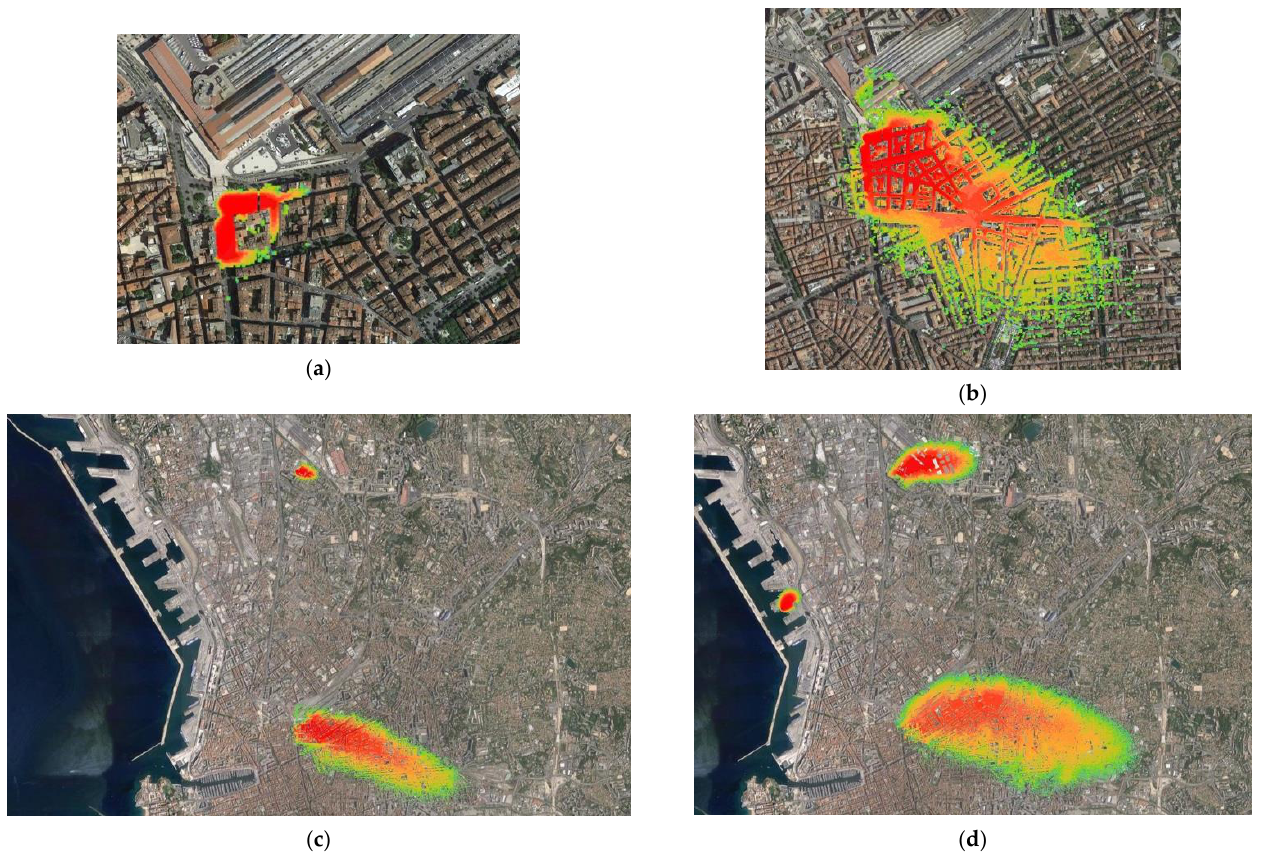
Figure 10. View, for the EMED project and the release in the Marseille domain, of the three plumes in the vicinity and further away from the releases: ( a ) 3 min after the first release; ( b ) 15 min; ( c ) 38 min; ( d ) 75 min. The scale, and the zoom level, vary between the views to cope with the evolution of the plumes. The threshold for 500 µg/m 3 of concentration is in red, while that for 1 µg/m 3 is in orange and that for 0.01 µg/m 3 is in green. North is at the top.